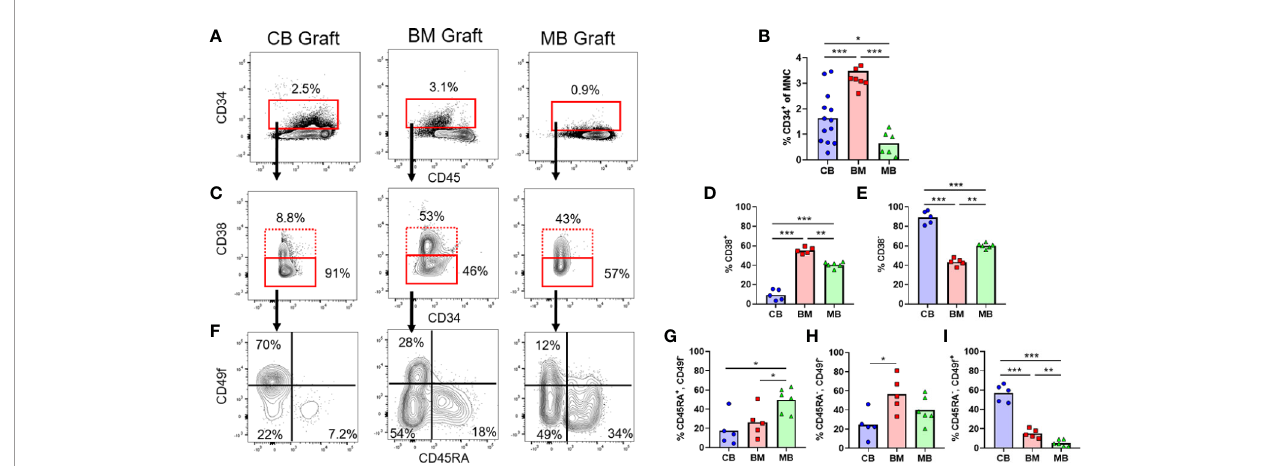
FIGURE 1 | Composition of human HSPC populations varies among graft sources. Flow cytometric analysis of HSPC populations in primary graft tissues. (A) Representative plots of panHLA-class-I + human cells from umbilical cord blood (CB), bone marrow (BM), and G-CSF mobilized peripheral blood (MB), showing the percentage of CD34 + cells (red box) in each graft. (B) Aggregated results showing percentage of CD34 + cells detected in individual graft samples. Symbols show results from individual samples of CB (blue), BM (red), or MB (green) tissue, with bars representing the arithmetic means. (C) Representative plots showing fl ow cytometric staining of CD34 + cells for CD38. (D, E) Aggregated results showing the percentage of cells in the CD38 + (D) or CD38 − (E) gates. (F) Representative plots showing fl ow cytometric staining of CD34 + CD38 − cells for CD45RA and CD49f. (G – I) Aggregated results showing the percentage of CD34 + CD38 − cells corresponding to uncommitted progenitors (CD45RA + CD49f − , G ), multipotent progenitors (CD45RA − CD49f − , H ), and long-term HSCs (CD45RA − CD49f + , I ). *p < 0.05; **p < 0.01; ***p <